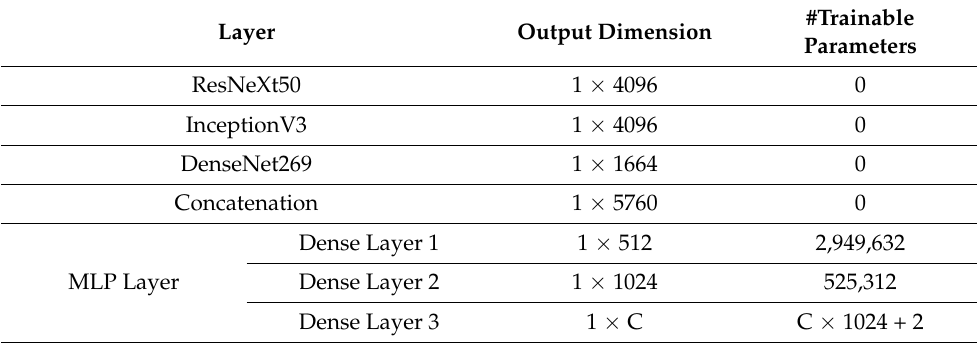
Table 2. Detailed description of the MLP-based classification network in our study (C means the number of classes).